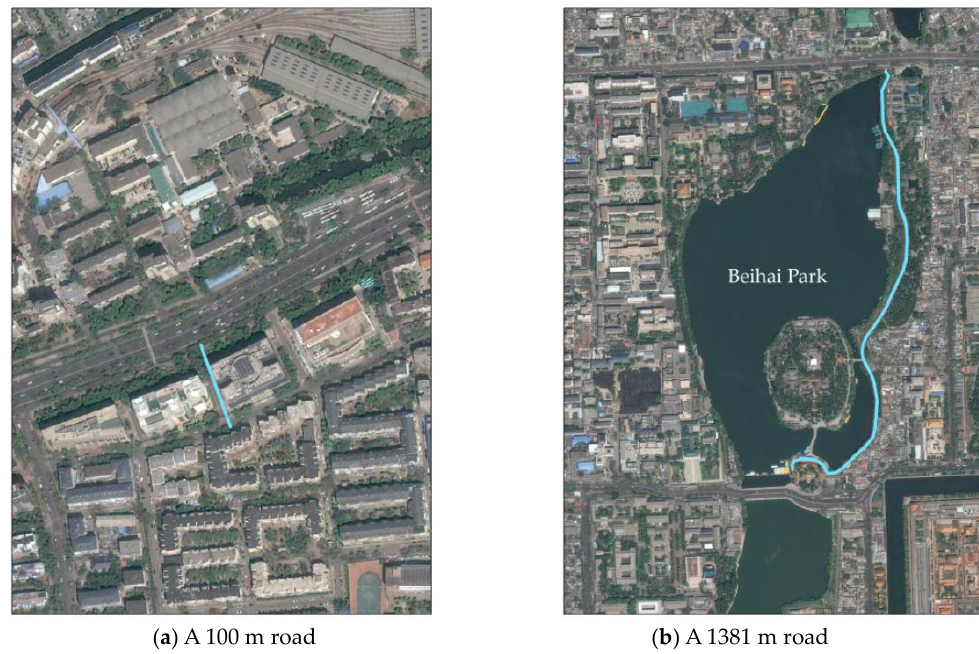
Figure 5. Schematic diagram of the road network in Xicheng District, Beijing.